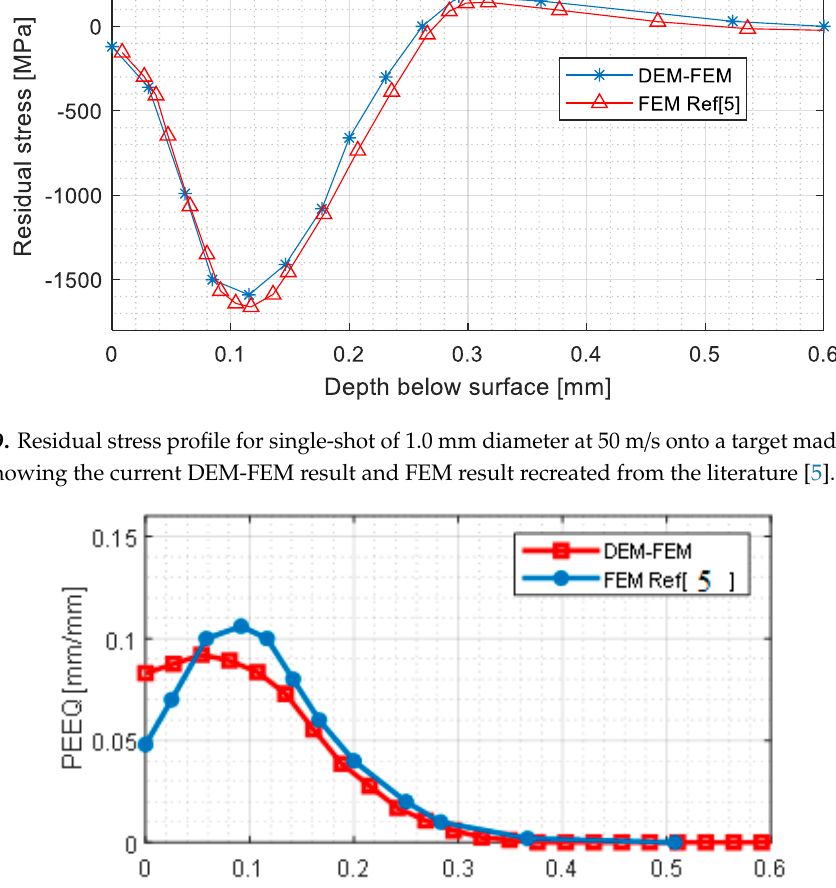
Figure 10. Equivalent strain profiles generated in 4340 steel impacted at 50 m/s by a single 1.0 mm diameter shot with coefficient of friction 0.1. Showing the current DEM-FEM result and FEM result recreated from the literature [5].